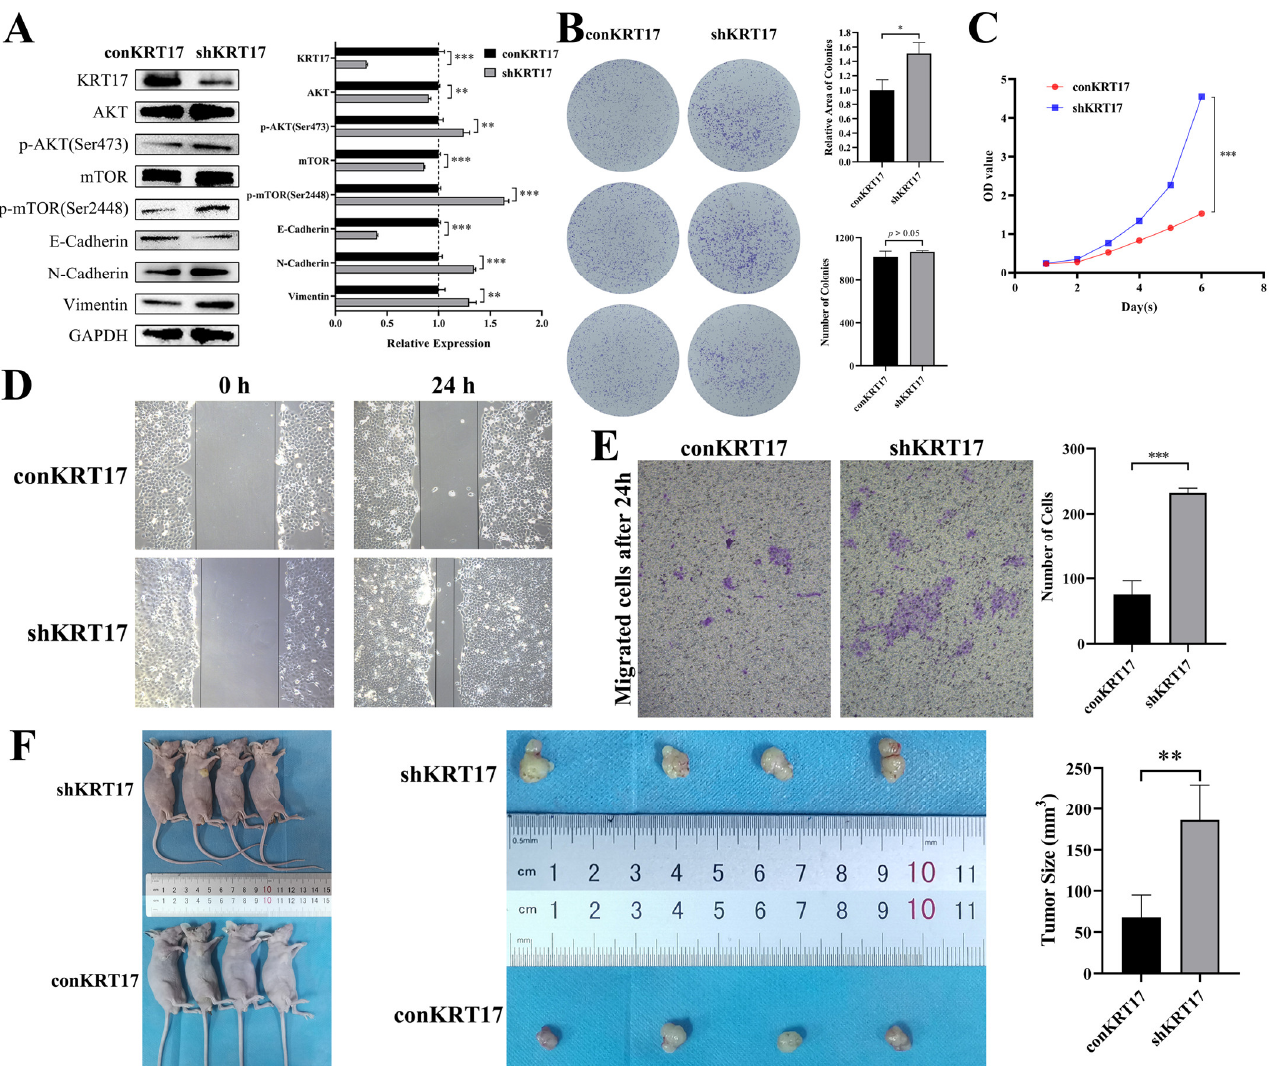
Figure 5. KRT17 exerted Anticancer effects on hypopharyngeal cancer and inhibited the AKT/mTOR and EMT pathways. ( A ) Phosphorylation levels of AKT and mTOR were significantly increased, E-cadherin was downregulated, N-cadherin and VIM was upregulated in the knockdown group versus the control group. ( B ) Colony formation assay showed that the number of colonies was not significantly different after knockdown of KRT17; however, the relative area was significantly increased. ( C ) CCK-8 assay showed that the cell proliferation was increased after knockdown of KRT17. ( D , E ) Scoring and Transwell experiments showed that knockdown of KRT17 significantly increased the migratory ability of tumor cells. The figures were captured under 10 × 10 microscope. ( F ) Tumorigenesis experiments involving KRT17 control and knockdown (shKRT17) groups in nude mice. * p < 0.05; ** p < 0.01; *** p < 0.001.